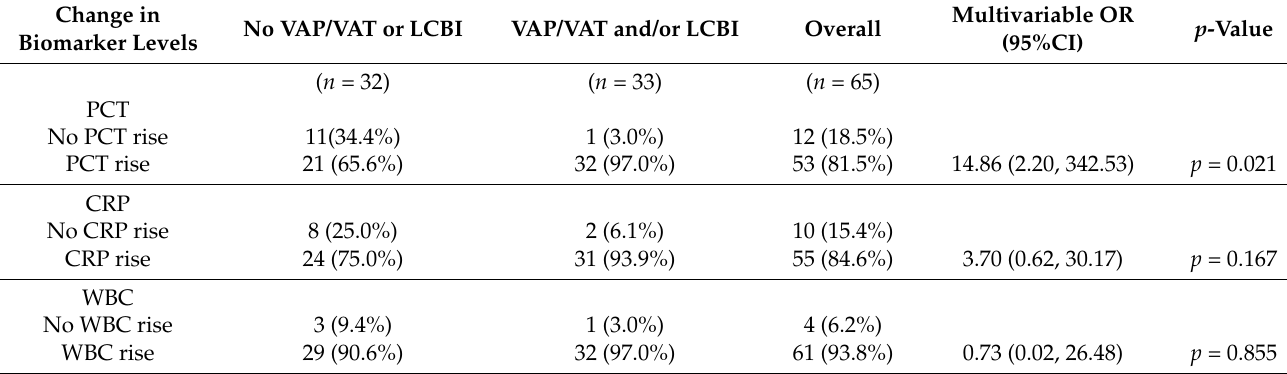
Table 2. Biomarker data of ICU COVID-19 patients who experienced VAP/VAT and/or LCBI and those who did not. Change